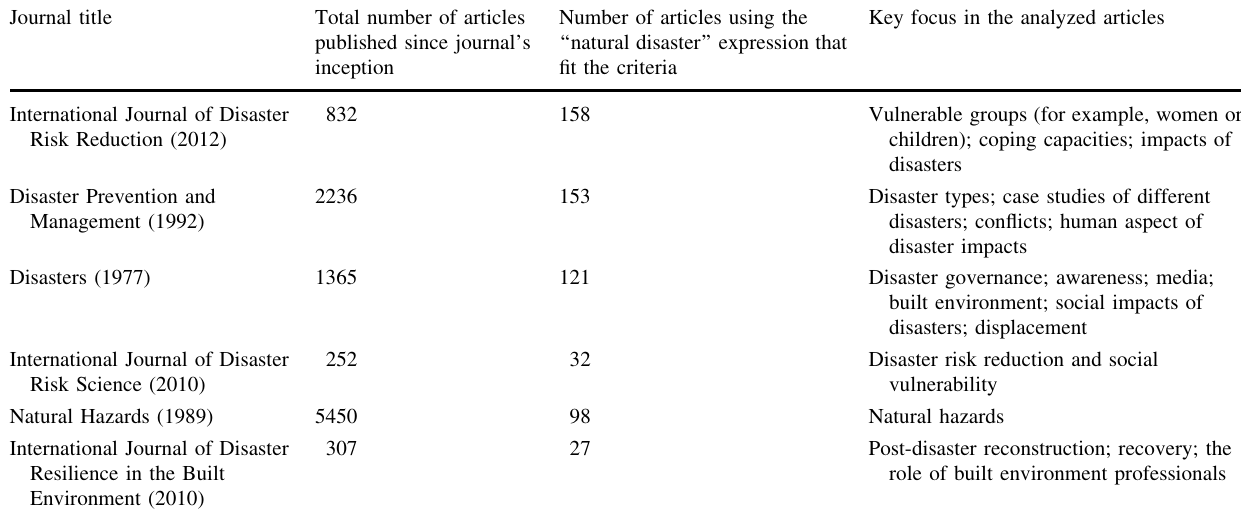
Table 1 Overview of the ‘‘natural disaster’’ expression usage in the 589 selected research articles in the six selected academic